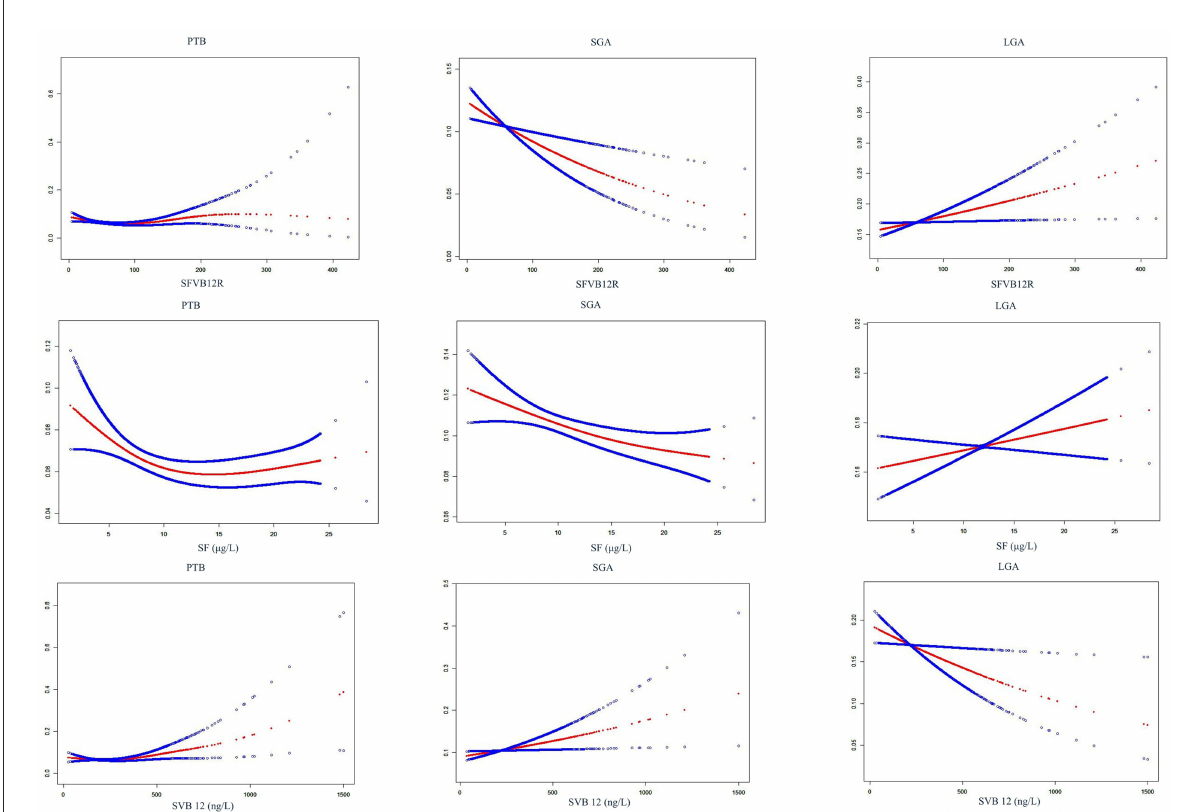
FIGURE3 Smooth curve fitting analysis of SF, SVB12, and SFVB12R with the risk of adverse birth outcomes. For SFVB12R vs. PTB, adjusting for maternal age, BMI, gravidity, parity, blood pressure, GDM, ICP, PE, PIH, and fetal sex; for SFVB12R vs. SGA/LGA, additionally adjusting for gestational age; for SF vs. PTB, additionally adjusting for SVB12; for SF vs. SGA/LGA, additionally adjusting for SVB12; for SVB12 vs. PTB, additionally adjusting for SF; for SVB12 vs. SGA/LGA, additionally adjusting for SF. SF, serum folate; SVB12, serum vitamin B12; SFVB12R, serum folate to vitamin B12 ratio; GDM, gestational diabetes mellitus; ICP, intrahepatic cholestasis of pregnancy; PE, pre-eclampsia; PIH, pregnancy-induced hypertension; PTB, pre-term birth; SGA/LGA, small/large for gestational